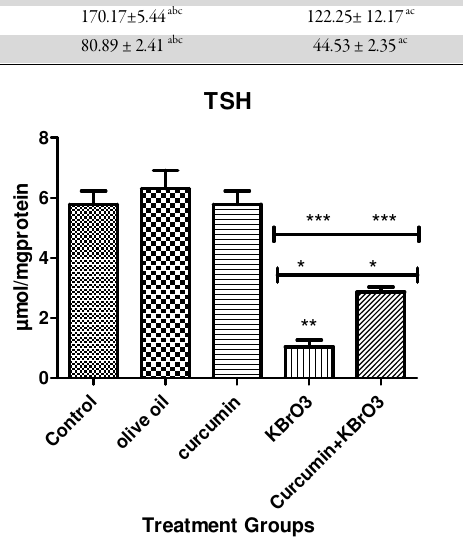
Effect of curcumin on total thiol (TSH) levels in KBrO3-induced liver oxidative damage. Data are presented as the mean ± SD (n = 6). * values are significantly (p<0.05) different from control, **values are significantly (p<0.05) different from curcumin+ KBrO3, ***values are significantly (p<0.05) different from curcumin. For details, see legend in Table 1